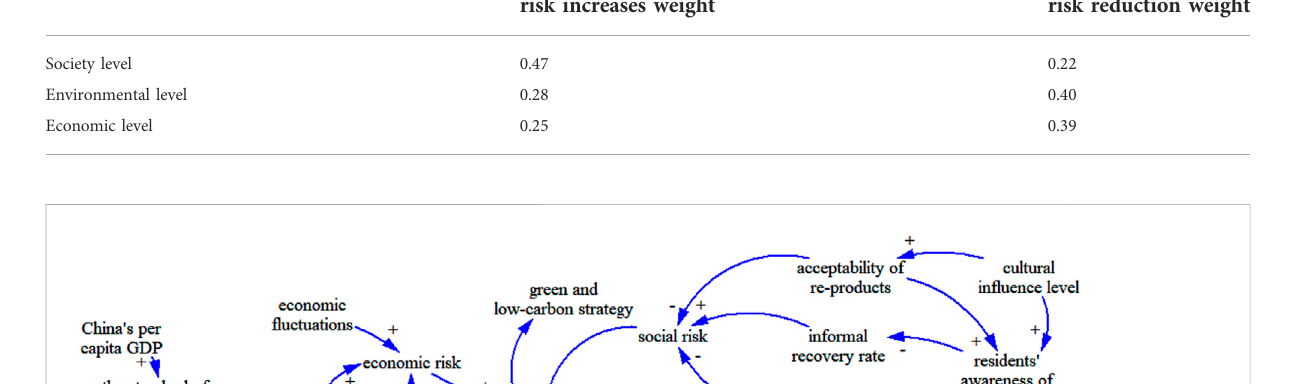
TABLE 3 Index weights of risks.